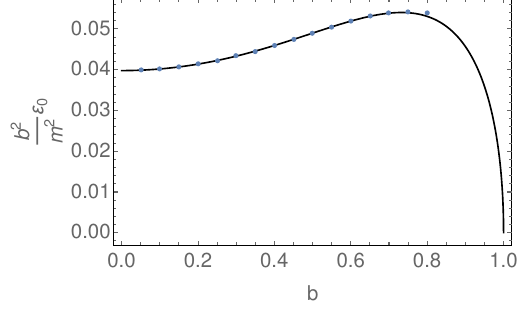
(b) Measured versus theoretical vacuum ener- gies, normalized with respect to m 2